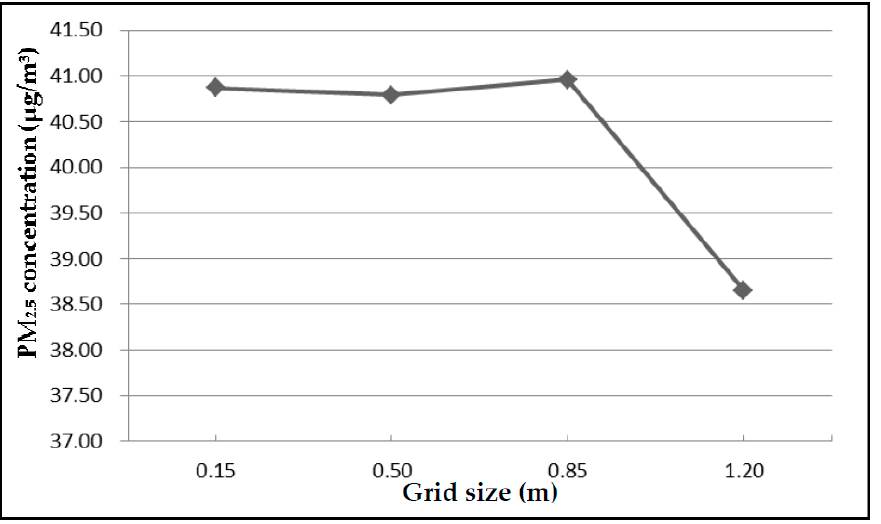
Figure 3. The relationship between grid size and average PM 2.5 value at the height of 1.5 m.